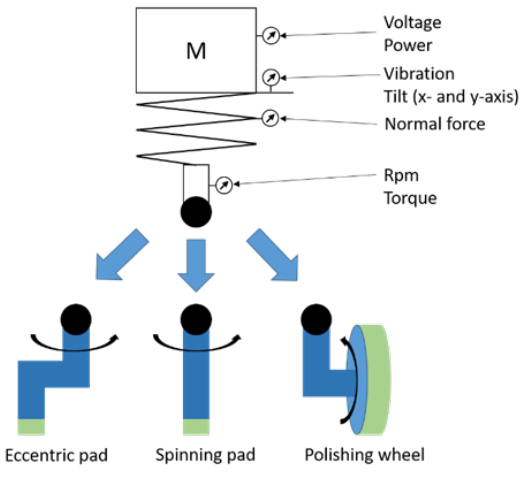
Fig. 1. Principle setup of the polishing head with different sensors and the possibility to use one of three different types of polishing methods (eccentric pad, spinning pad or polishing wheel); the black arrows indicate the movement for each method.